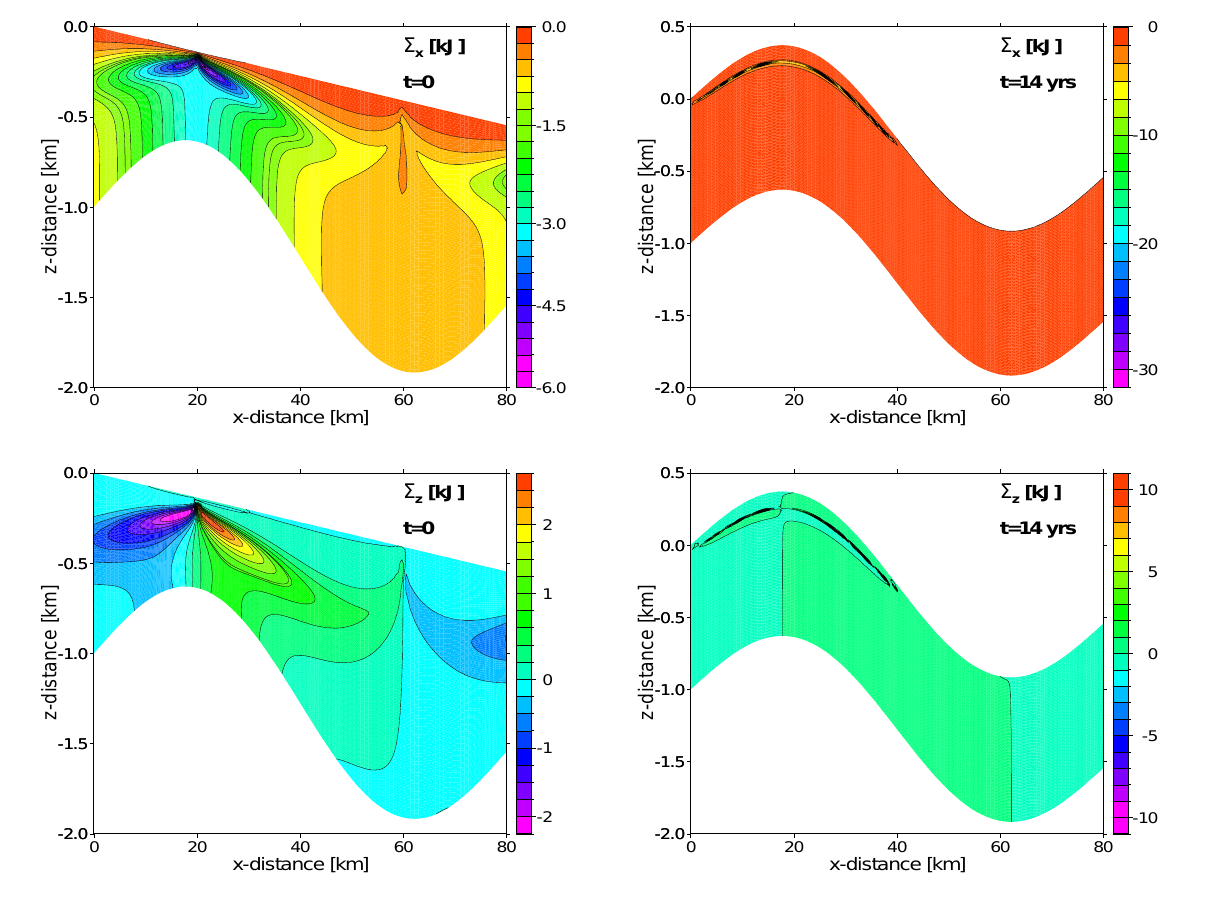
Fig. 4. 2-D flowline time dependent experiment – ice stream flow over bumpy bed. The graphs show the compensatory horizontal 6 x and vertical 6 z stress terms (in kJ) at the beginning (left) and at the time when the steady-state solution is reached (right). At the beginning the stress terms have the largest values over the bump. At the steady-state solution, they are zeroes almost everywhere except a small surface layer over the